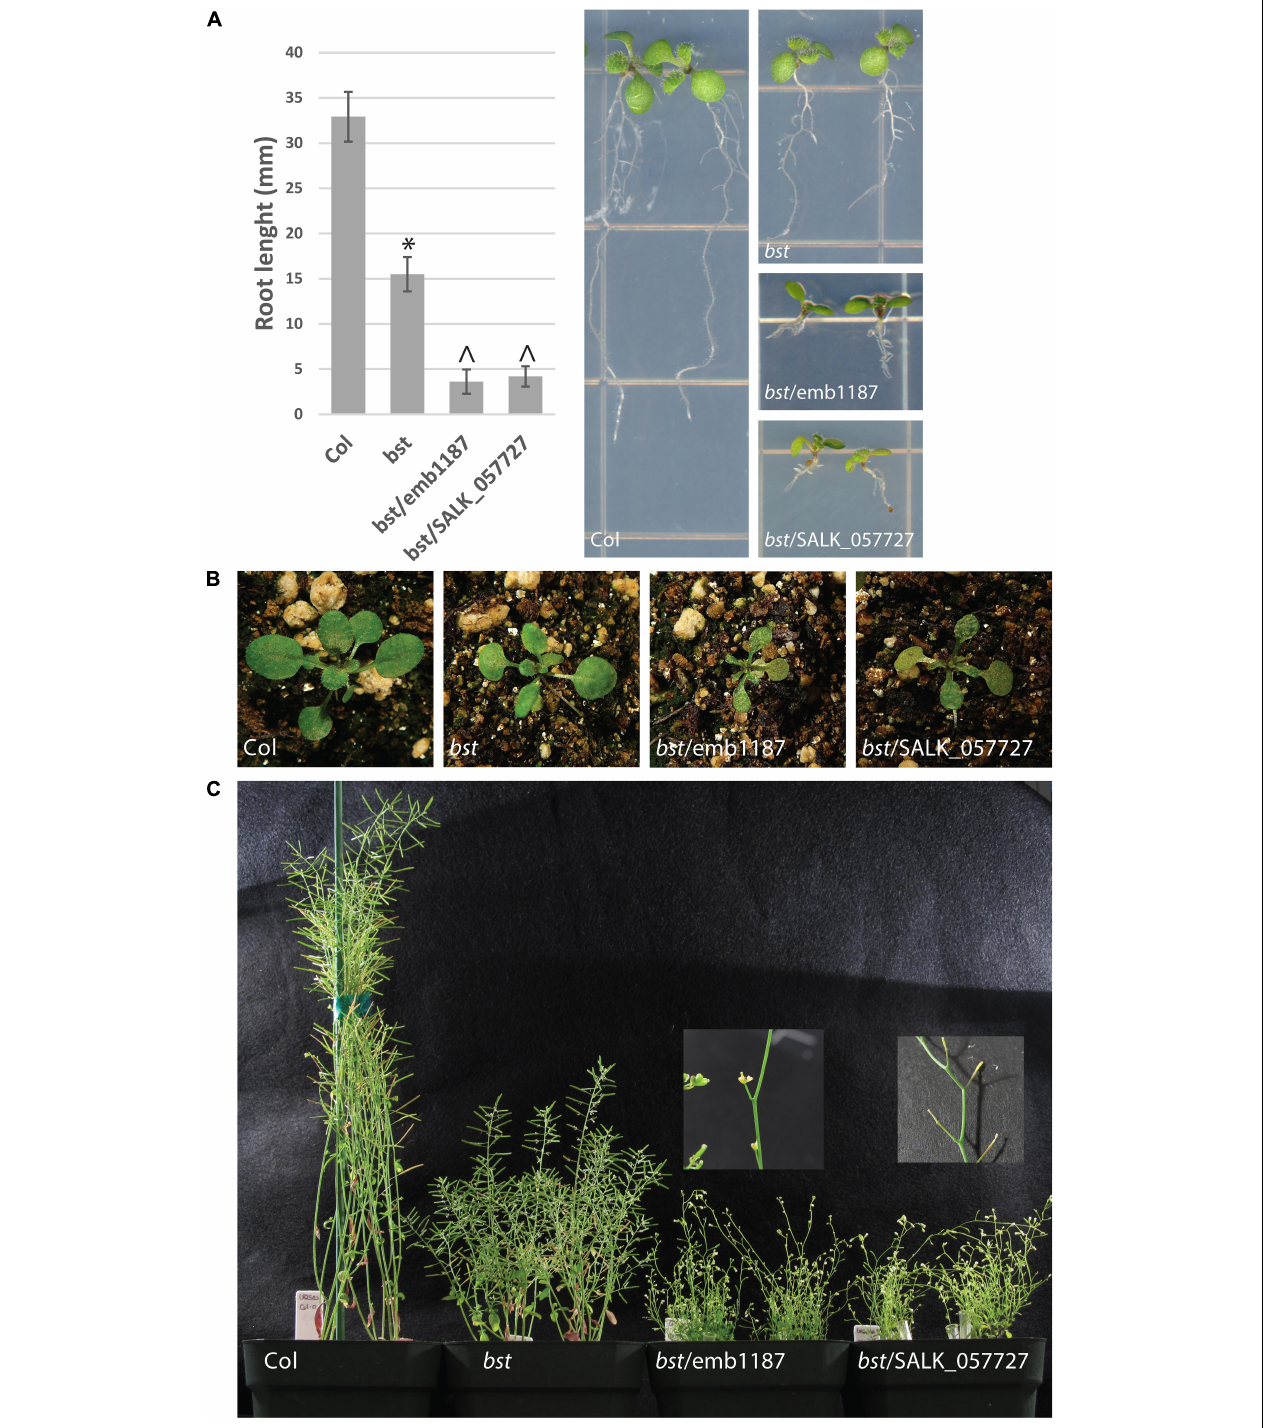
FIGURE 3 | bumpy stem root and shoot phenotypes and genetic complementation. bst plants were crossed to heterozygous emb1187 and SALK_057727 plants, both of which contain T-DNA insertions in CEK4 . Seven day old bst / bst plants were imaged and their root lengths were measured. Root lengths were compared using unpaired two-tailed t -tests. The symbol “*” indicates a difference from Col with a p -value < 10 - 10 . The symbol “ˆ” indicates a difference from both Col and bst with a p -value < 10 - 7 . Error bars are SD (A) . bst vegetative rosettes are smaller than wild-type. This phenotype is enhanced when the bst allele is combined with either emb1187 or SALK_057727 (B) . The height of mature plants is reduced in bst plants and even more so in bst / emb1187 and bst /SALK_057727 plants. bst / emb1187 and bst /SALK_057727 plants are sterile (C) .